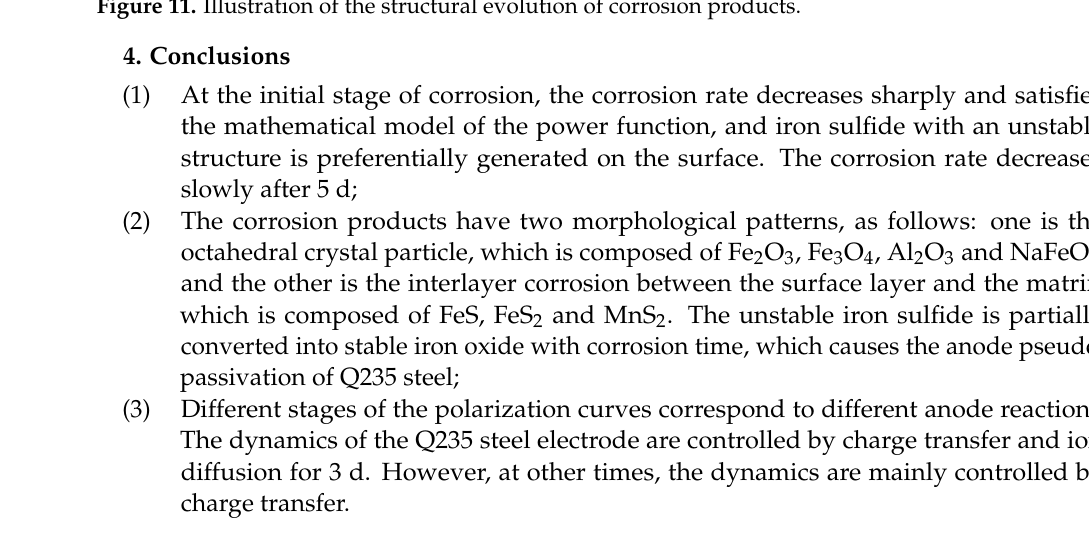
Figure 11. Illustration of the structural evolution of corrosion products.